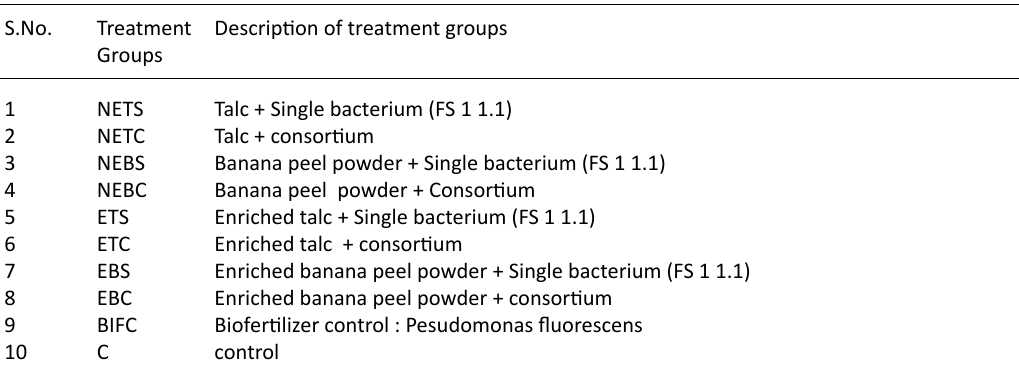
Table 2. Experimental setup and treatment designs for the in vivo pot culture study S.No.